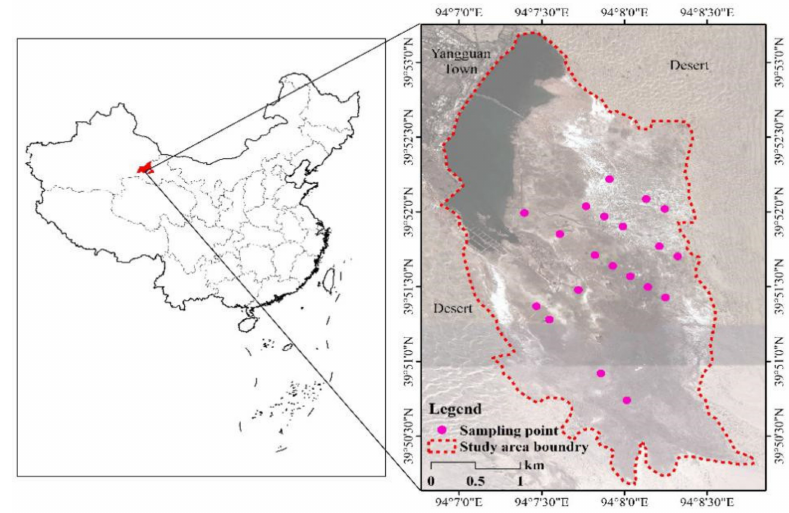
Figure 3. Location of sampling points in Yangguan